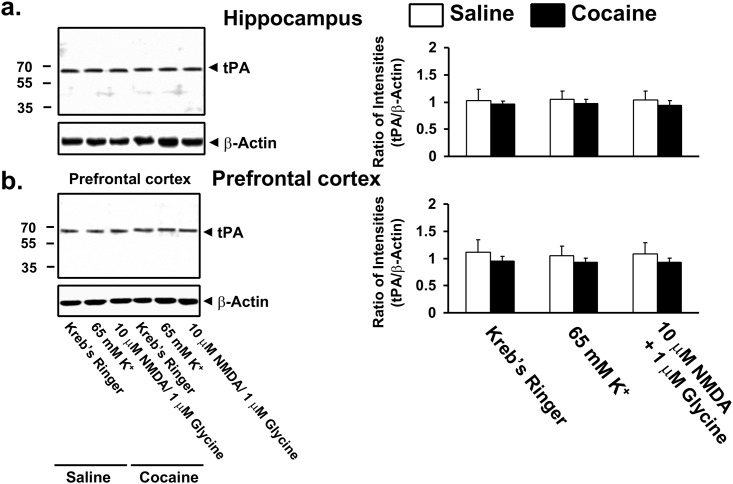
Prenatal cocaine exposure did not alter the expression level of tPA in both hippocampi (a) and PFCX (b).The expression level of tPA in 50 μg post-mitochondrial (P2) fractions prepared from 10 μM NMDA/1 μM glycine or 65 mM K+ superfused hippocampal and PFCX slices of P21 prenatal cocaine- and saline-exposed rats were compared by Western blotting. Brain slices (100 μm x 100 μm x 3 mm) were superfused with 0.2 ml/min LMKR for 30 min or with 10 μM NMDA/1 μM glycine in LMKR for 10 min or 65 mM K+-depolarization for 1 min followed by 9 min with LMKR. Slices were collected, homogenized and centrifuged to obtain post-mitochondrial fractions. The blots were stripped and re-probed with anti-β-actin to validate equal loading. Densitometric quantification of blots revealed no discernible differences in tPA expression level. n = 4 (2 males and 2 females). Data are mean ± s.e.m. of the ratio of tPA to β-actin optical intensities.